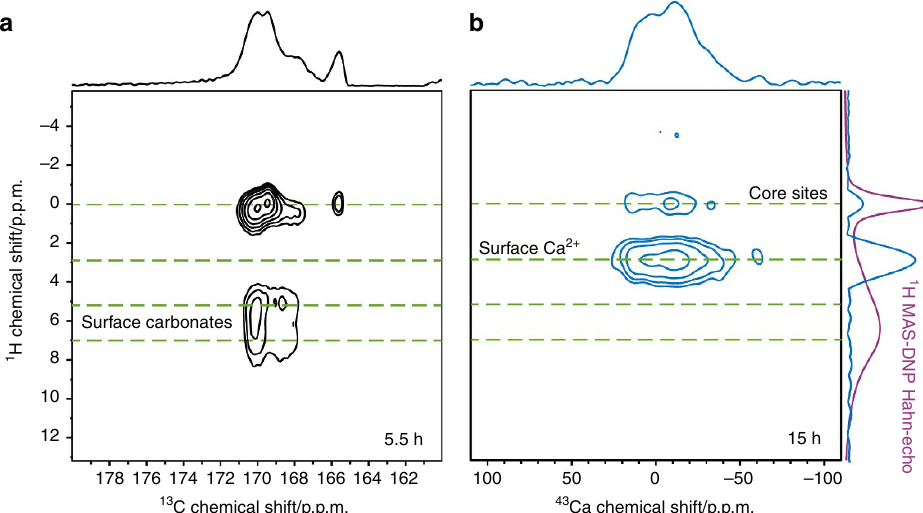
Figure 4 | MAS-DNP HETCOR spectra of C–HAp. Both were recorded at B 100K, 9.4T, and using a MAS rate of 8.5kHz. ( a ) 1 H– 13 C HETCOR spectrum with associated 13 C skyline projection (top), recorded using a CP contact time of 7ms. ( b ) 1 H– 43 Ca HETCOR spectrum with associated 43 Ca (top) and 1 H (right) skyline projections, recorded using a CP contact time of 3ms. Both spectra were recorded using FSLG homonuclear decoupling 48 during the indirect acquisition and SPINAL-64 heteronuclear decoupling 49 during the direct acquisition. Also shown (far right, purple) is the DNP-enhanced 1 H Hahn-echo MAS NMR spectrum, for